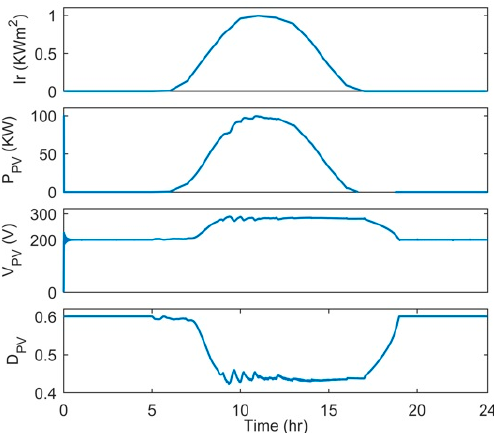
Figure 12. Performance of the PV system.